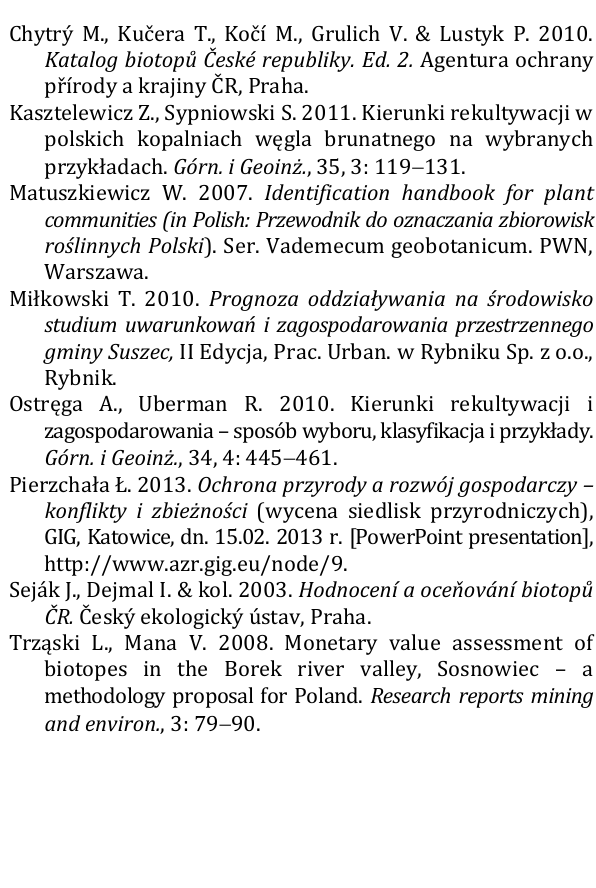
Fig. 5. Monetary values for particular